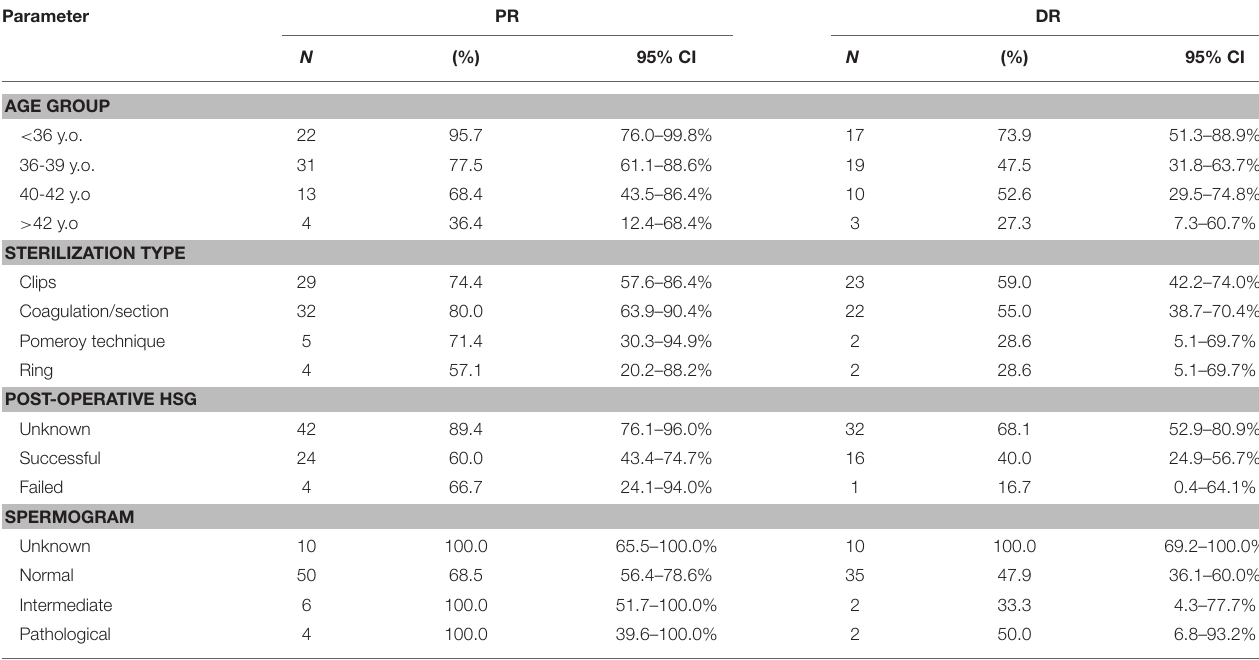
TABLE 1 | Pregnancy (PR) and delivery (DR) rates (%) with respective 95% confidence intervals (95% CI, based on one-sample proportion test for the true underlying rates) at the end of the follow-up period according to various factors of interest. Parameter PR